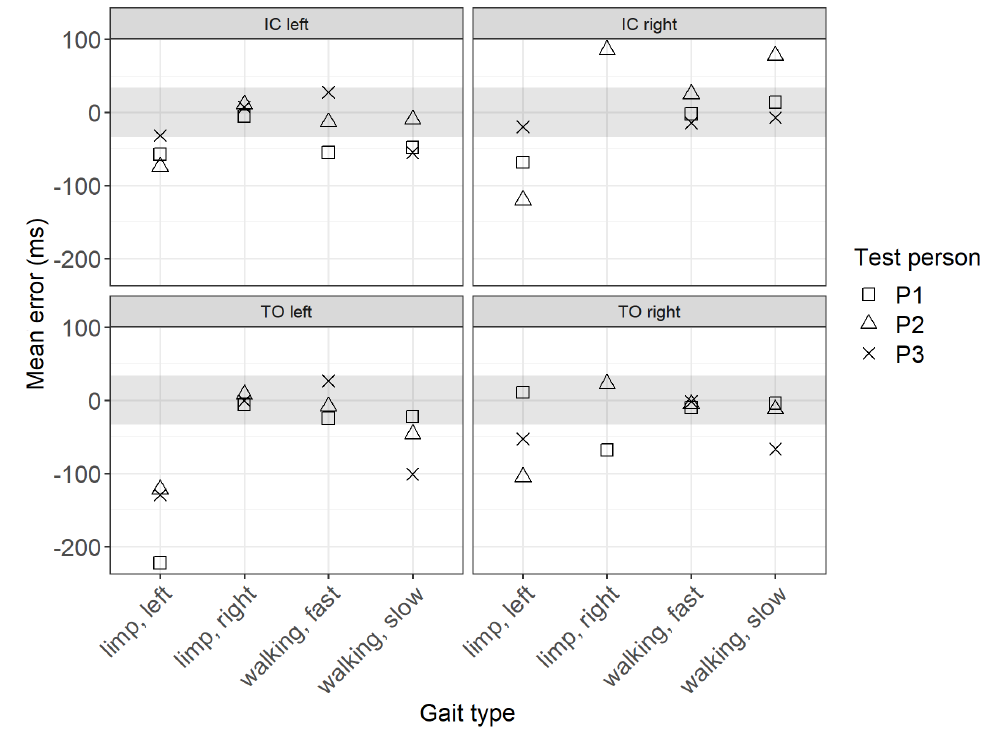
Figure 5. Mean error between the ground truth and sensor